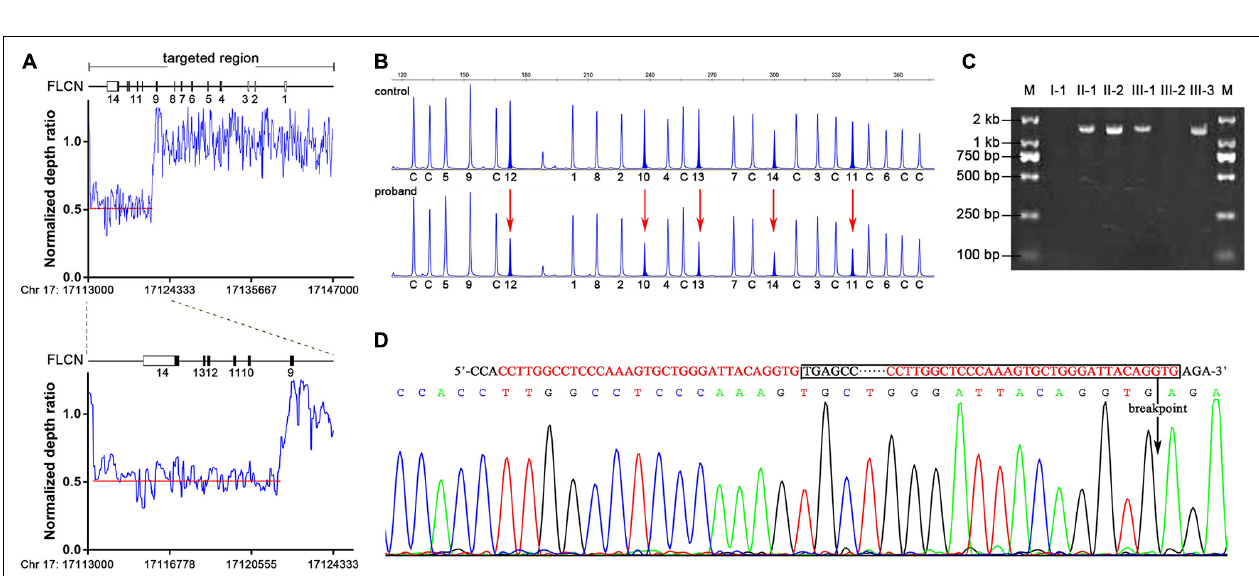
FIGURE 2 | Identification of FLCN intragenic deletions and breakpoint analysis in II-2. (A) Representation of the normalize depth ratio of 20-bp intervals in FLCN gene detected by NGS method. The red dotted lines represent the average ratio of the deletion area. (B) MLPA analysis showed heterozygous exonic deletions (red arrows) in II-2 compared with the control individual. The characters and numbers below the probes indicate exons and control probes. (C) PCR products of junction fragments were separated by 2% agarose gel electrophoresis. The numbers above the lanes corresponded to the subjects of the Pedigree in Figure 1A . (D) Bidirectional sequencing of the junction region. The sequences of microhomology between the up and downstream breakpoints were marked in red; boxed nucleotides indicate the deletion and an arrow indicate the location of the deletion.